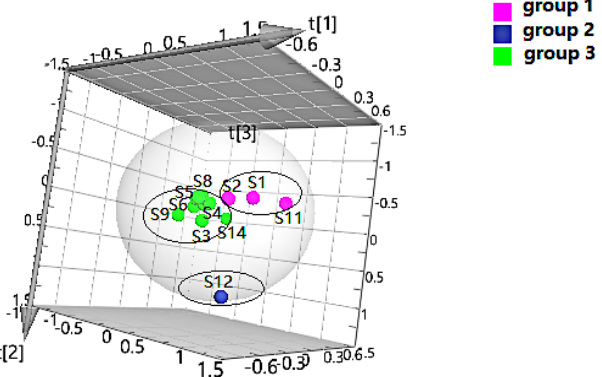
Figure 6. PLS-DA of Cortex Periplocae from different producing areas.